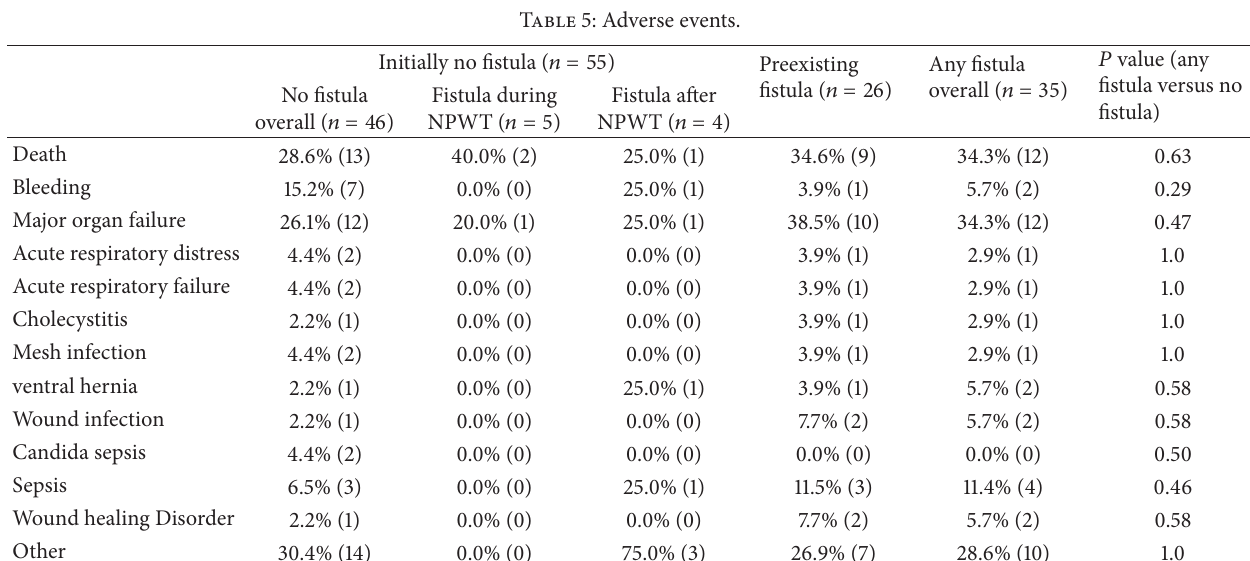
Table 5: Adverse